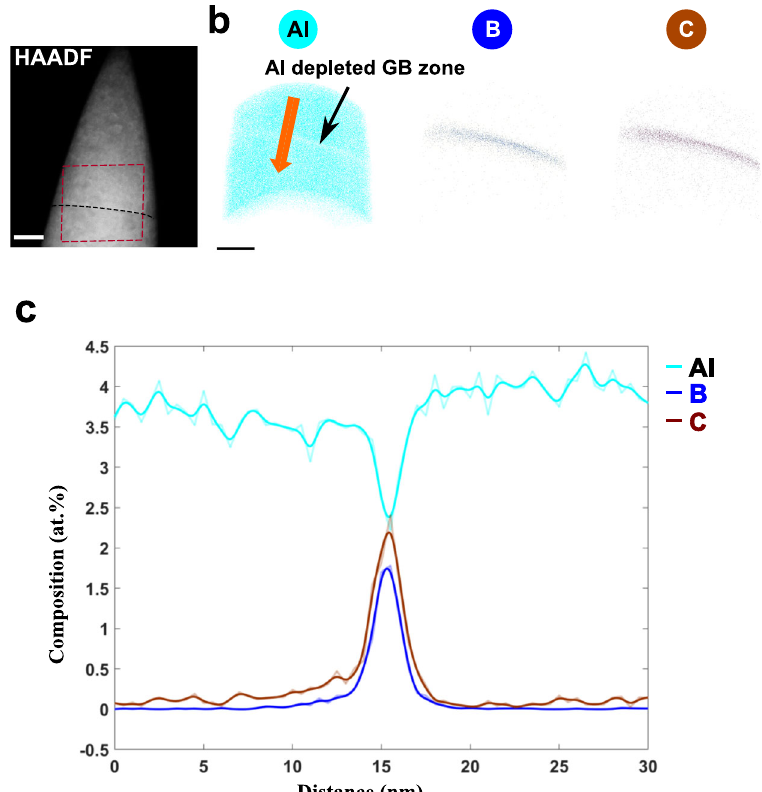
Fig. 5 Correlative STEM-APT study of the Σ 5 GB. a HAADF-STEM image of the needle shaped APT specimen with both grains in [0 0 1] orientation. The GB is labeled with a black dashed line. b The atom maps of Al, B and C reconstructed from the volume outlined by a red rectangle in a). At the GB, a depletion of Al and enrichment of B and C is observed. c The corresponding composition pro fi les extracted from a cylindrical region marked by an orange arrow in ( b ) across the GB shows a decrease of Al and increase of B and C concentration at the GB. Scale bar in ( a ) is 20 nm and in ( b ) 10